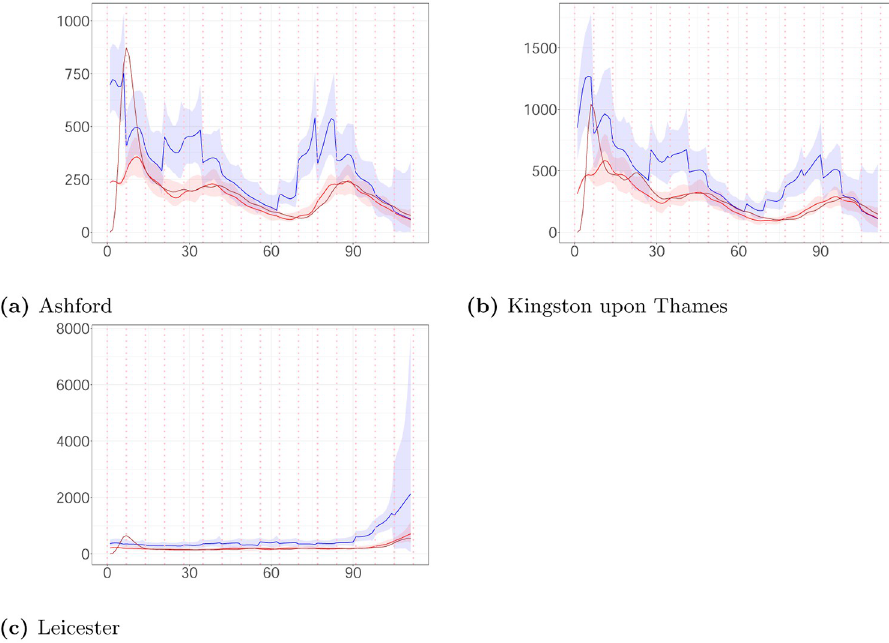
Fig 12. The estimated daily number of events derived by the method of Koyama et al. [10] (brown line), the estimated latent intensity (posterior median (blue line); 99% CI (ribbon)) and the estimated intensity of observed cases (posterior median (red line); 99% CI (ribbon)) plotted against time. (a) Ashford. (b) Kingston upon Thames. (c) Leicester.